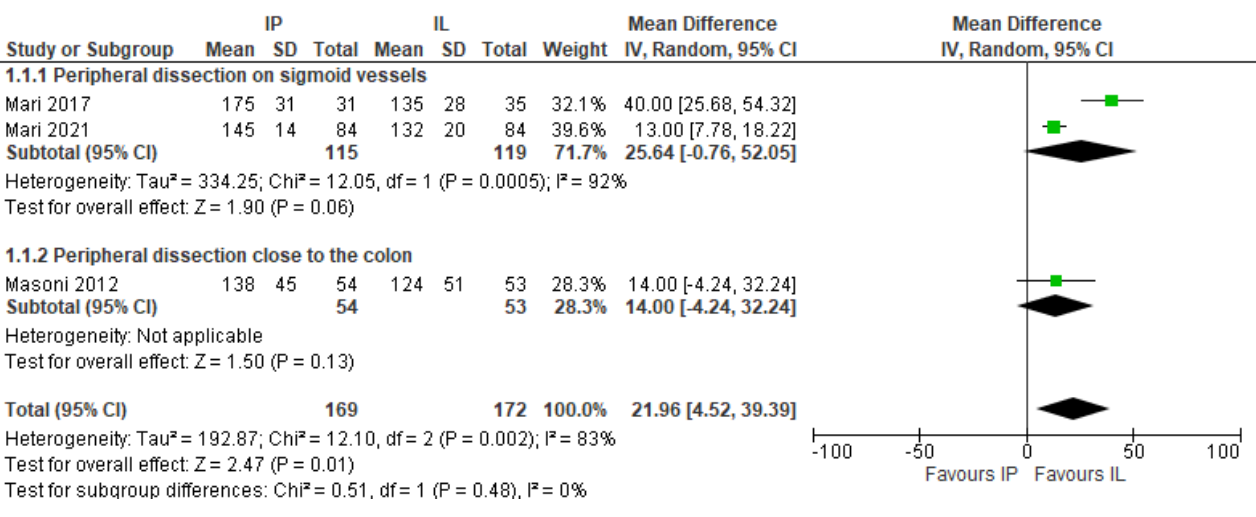
Figure 9. Operative time. Risk ratio for different IMA preservation techniques.